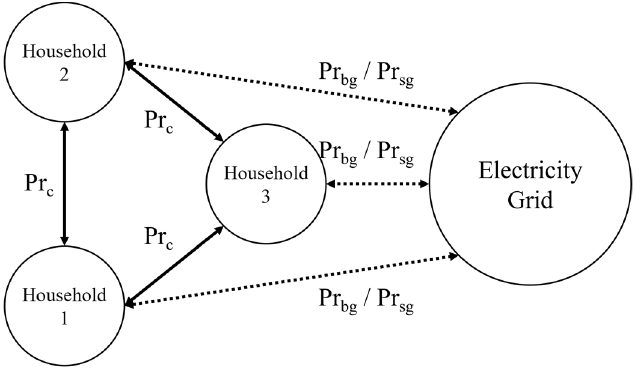
Figure 6. Example of electricity trading between a three-household community and the main elec- tricity grid. ity